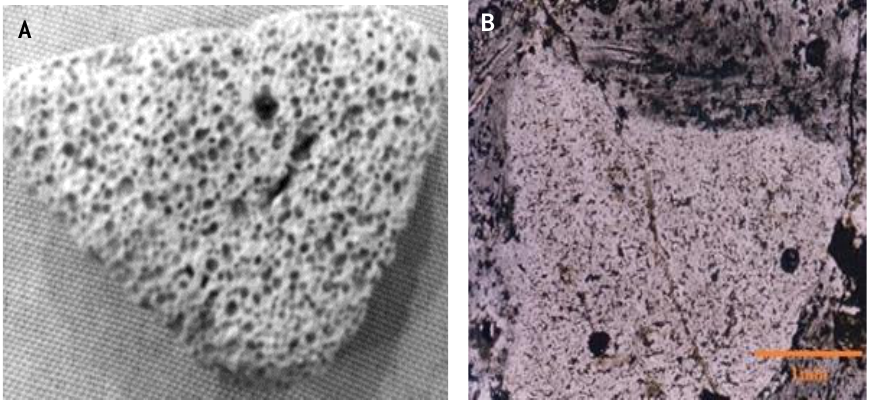
Figure 3. Photograph of pumice samples. ( A ) Photograph of a hand-specimen; ( B ) photomicrograph under a transmitted microscope. Table 3. Geochemical composition of pumice rock in (wt %). SiO 2